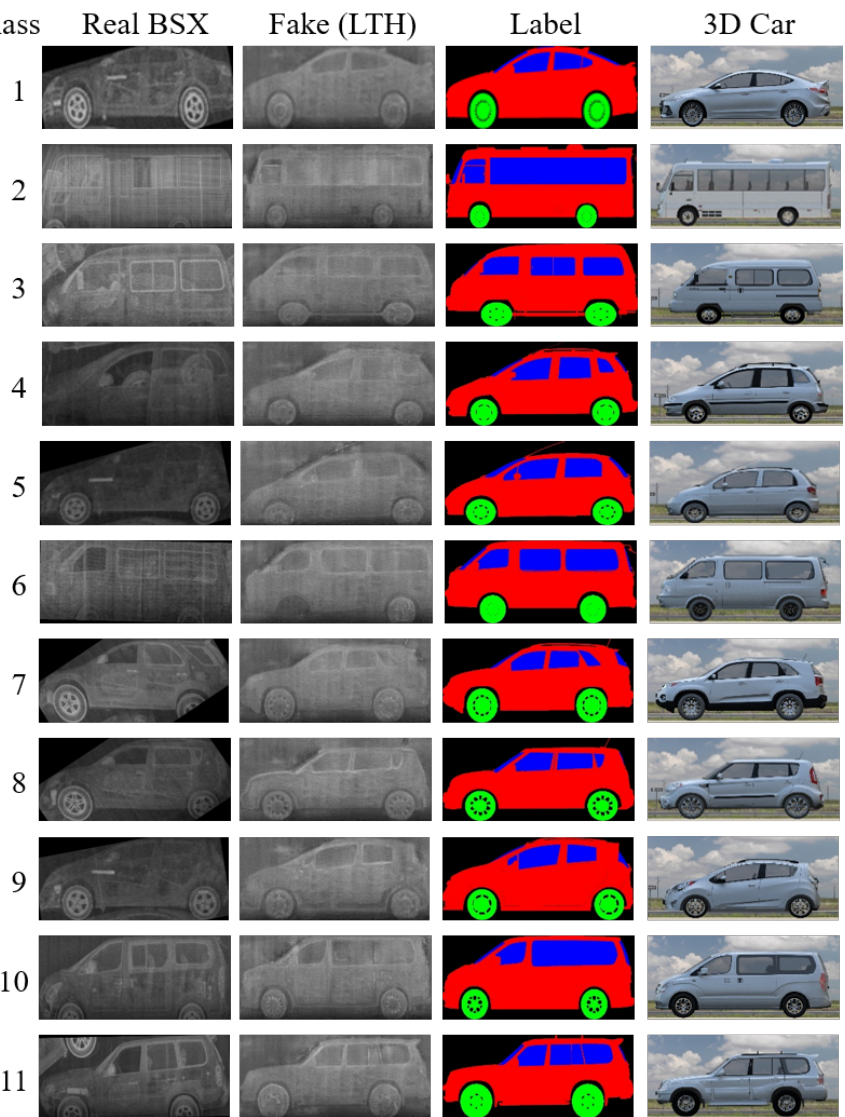
Figure A1. Real and Fake (LTH) BSX images used for classification. Fake images were